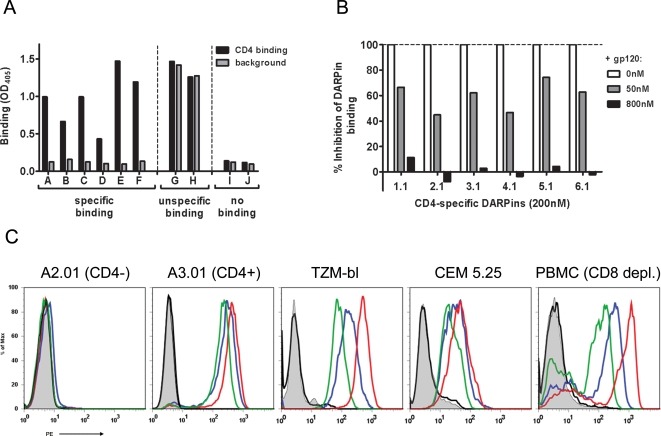
DARPins interact specifically with CD4 and compete with gp120 for binding to CD4.(A) Binding of DARPins, in the form of crude bacterial lysates, to CD4-IgG2 (black) is determined by ELISA and compared with binding to the capture antibody alone (gray). DARPins A–F show specific binding to CD4-IgG2, a property that was confirmed by further tests using the purified proteins. DARPins G and H reveal nonspecific binding whereas I and J are examples of library members that do not recognize the target protein. (B) Competition ELISA using soluble gp120 as competing ligand. Shown is binding of 200 nM of the CD4-specific DARPins 1.1 to 6.1 in competition with 0 nM, 50 nM and 800 nM gp120. Binding of DARPins alone was defined as 100% and background binding as 0%. (C) Binding of the DARPins to cellular CD4 was tested using A2.01 cells (CD4−), the CD4 expressing lines A3.01 cells, TZM-bl cells, CEM 5.25 cells and CD8-depleted PBMC as source of primary CD4 T cells. CD4-specific DARPins D3.1 (blue), D23.2 (red), and of a control DARPin, E3_5 (black), an unselected library member binding to the various cell types are shown. PE-labeled CD4-antibody (clone Q4120, Sigma) (green) was used as positive control and a PE-labeled goat-anti-mouse antibody (shaded in gray) as negative control. The shifts in fluorescence intensity correspond to the differences in affinities of the DARPins for CD4 (see Supporting Table S1). Representative data from 2–4 independent experiments are shown.